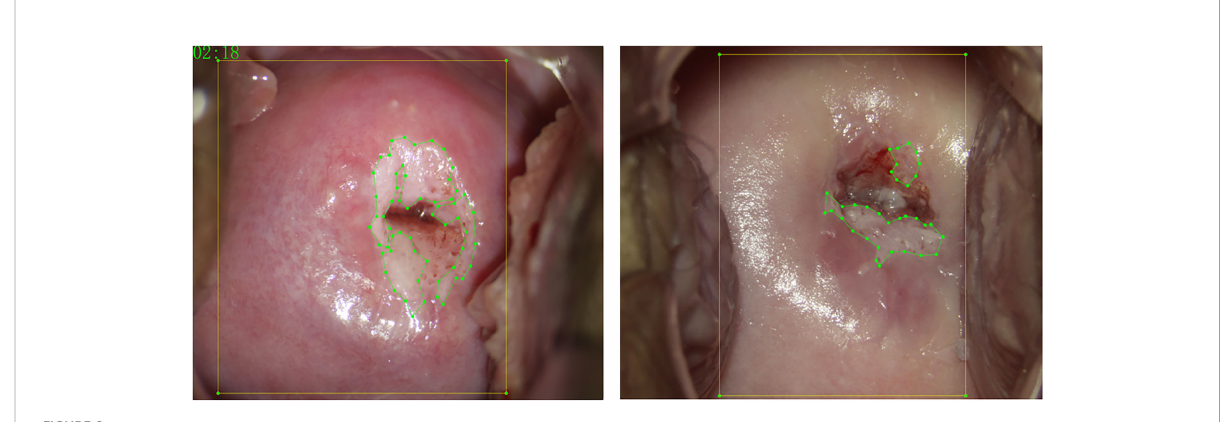
FIGURE 2 Annotation schematic